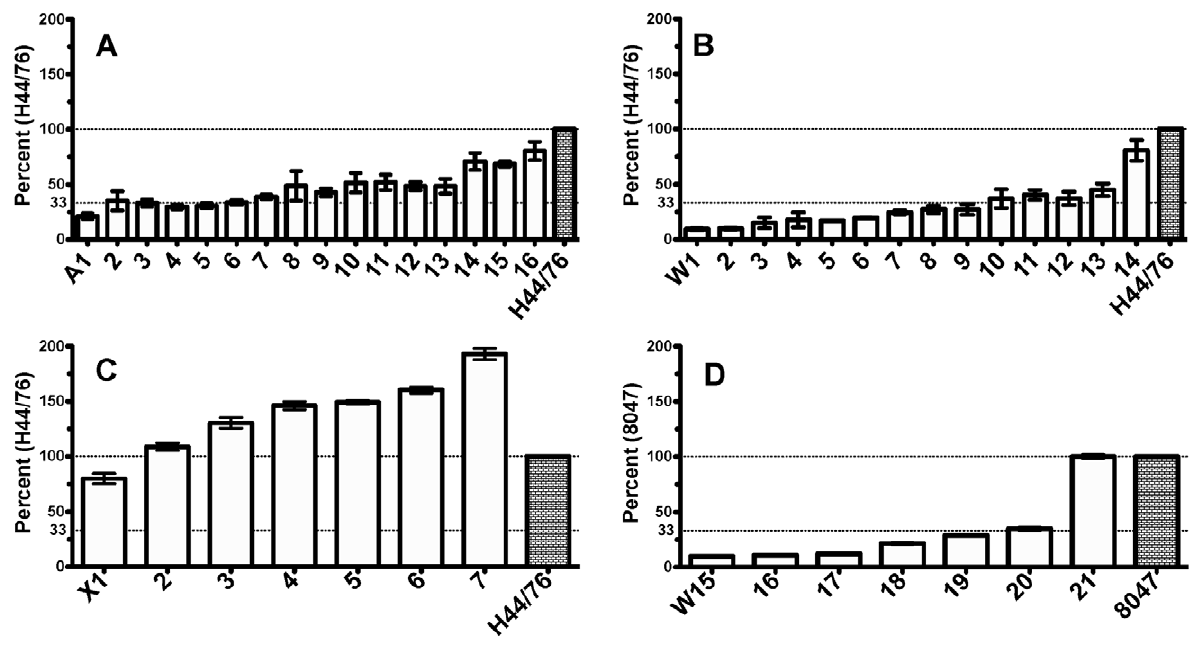
Figure 3. Expression of fHbp by representative African isolates as measured by a quantitative Western blot. Panel A, serogroup A isolates with fHbp ID 4 or 5; Panel B, serogroup W-135 isolates with fHbp ID 9; Panel C, serogroup X isolates with fHbp ID 73 or 74; and Panel D, serogroup W-135 isolates with fHbp ID 22 or 23. Bars in Panels A to C represent mean percentages (ranges) compared with expression of fHbp by the reference group B strain H44/76, which is a relative high expresser of fHbp ID 1 (variant group 1). Bars in Panel D are expression of fHbp compared with expression by reference group B strain 8047, which is a relative high expresser of fHbp ID 77 (variant group 2). Isolates with means below 33% were categorized as low fHbp expressers, and above 100% were defined as high expressers (See